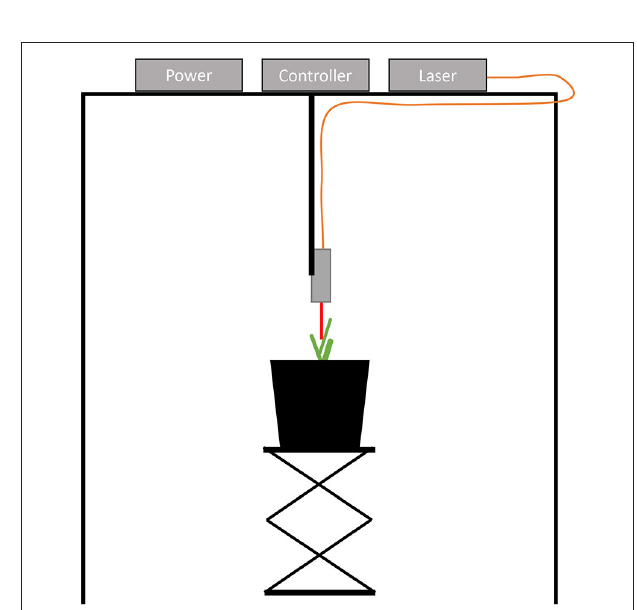
FIGURE 2 | Diagram of laser interlock and manual targeting method for the CW 25W 975nm fiber-coupled diode laser.